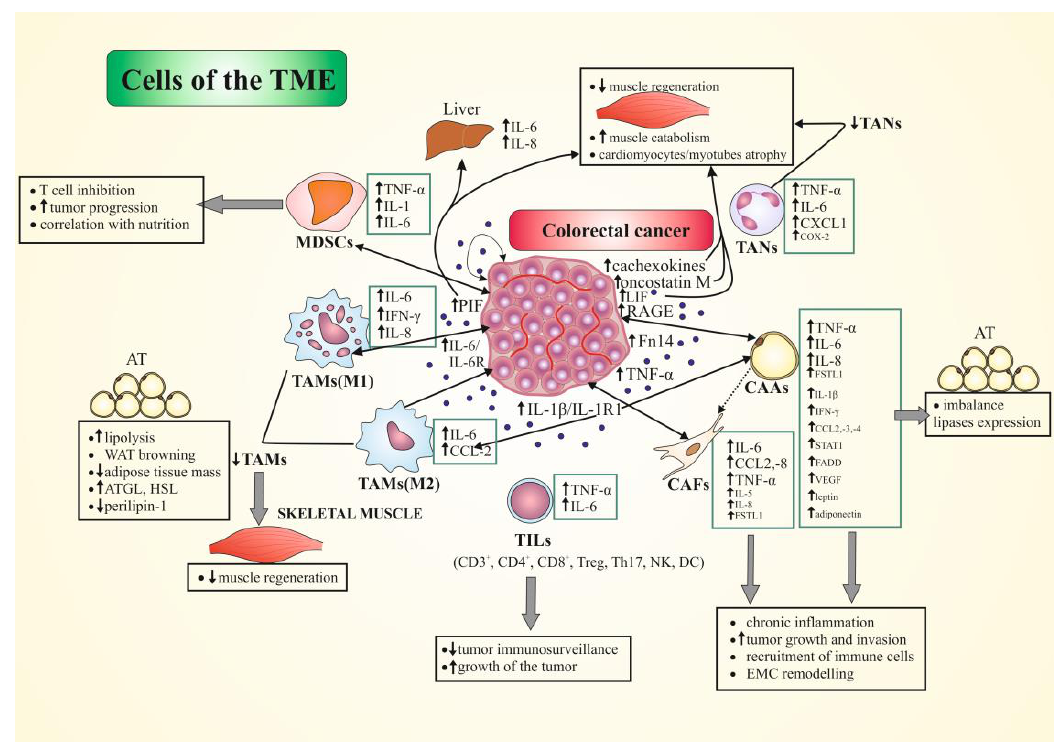
Figure 1. Schematic illustration of the tumor microenvironment (TME) cells involved in the development of colorectal cancer (CRC) cachexia through the secretion of specific products. [ ↑ , ↓ —increase/decrease; AT—adipose tissue; ATGL—adipose triglyceride lipase; CAAs—cancer-associated adipocytes; CAFs—cancer-associated fibroblasts; CCL2,- 3, -4, -8—the chemokine (C-C motif) ligand 2/3/4/8; CD3 + —cluster of differentiation 3 + , etc.; COX-2—cyclooxygenase-2; CXCL8—the chemokine (C-C motif) ligand 8/IL-8; FADD- FAS-associated death domain; Fn14—the cognate receptor of the TWEAK of the TNF/TNFR superfamily; FSTL1—follistatin-related protein 1; HSL—hormone-sensitive lipase; IFN-γ—interferon gamma; (IL-) 6R—(interleukin) 6 receptor; LIF—leukemia inhibitory factor; M1/M2—two phenotypes of macrophages; MDSCs—myeloid-derived suppressor cells; PIF—proteolysis-inducing factor; RAGE—receptor for advanced